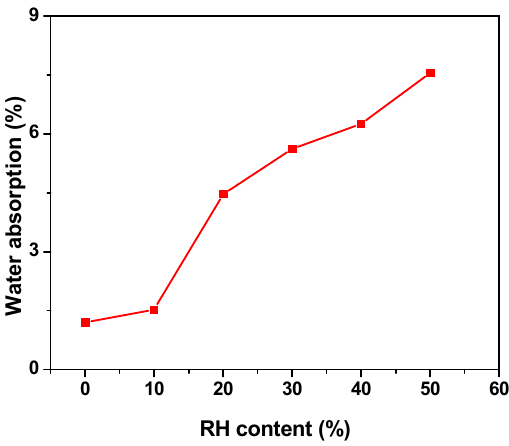
Figure 6. Effect of various RH content on water absorption.